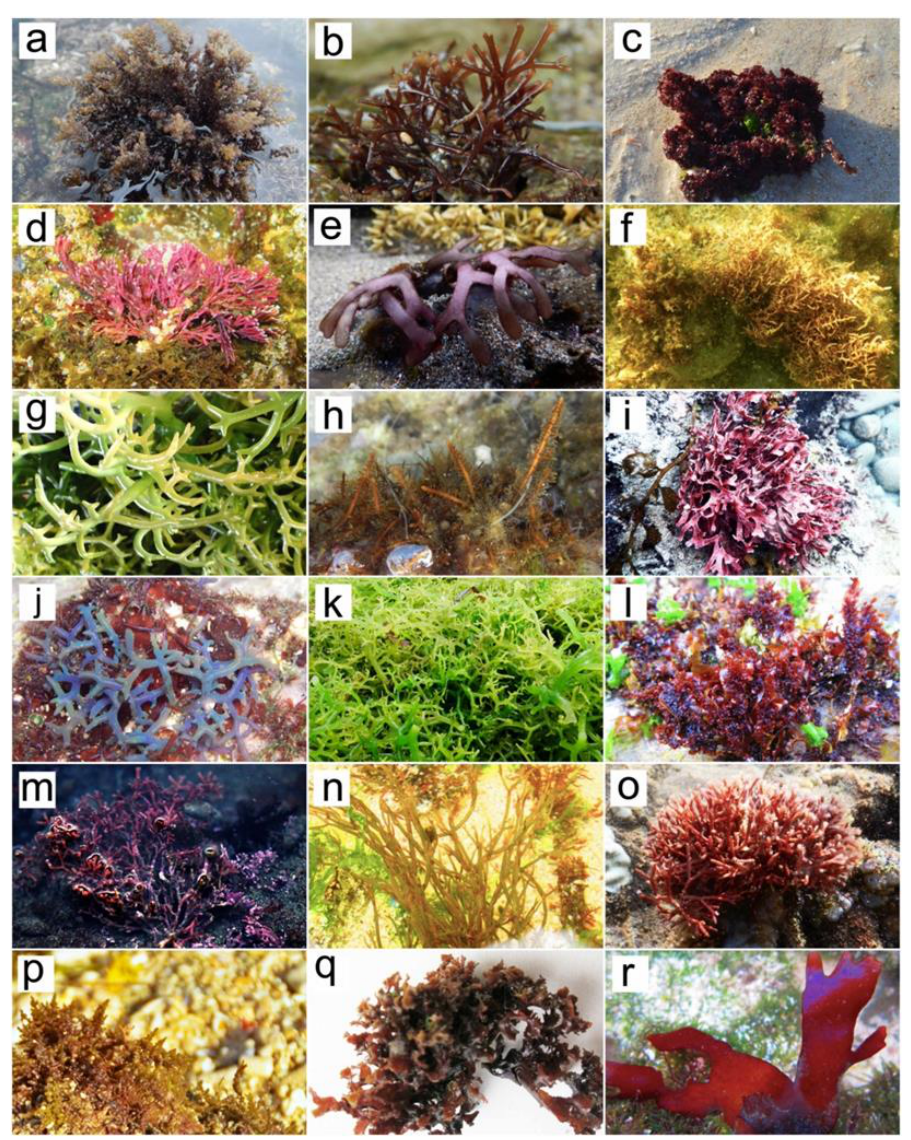
Figure 7. Red seaweed species from Indonesia with potential photoprotectant and antiphotoaging properties. ( a ) Acanthophora spicifera ; ( b ) Ahnfeltiopsis sp.; ( c ) Amansia sp.; ( d ) Amphiroa sp.; ( e ) Dichotomaria marginata ; ( f ) Ganonema sp.; ( g ) Eucheuma cottonii ; ( h ) Gelidiella acerosa ; ( i ) Gymnogongrus sp.; ( j ) Hypnea sp.; ( k ) Eucheuma spinosum ; ( l ) Gelidium sp.; ( m ) Galaxaura sp.; ( n ) Gracilaria sp.; ( o ) Jania rubens ; ( p ) Laurencia sp.; ( q ) Mastocarpus stellatus ; ( r ) Palmaria palmata . Table 4. Red seaweeds of Indonesia as potential MAAs producers . Type of MAA